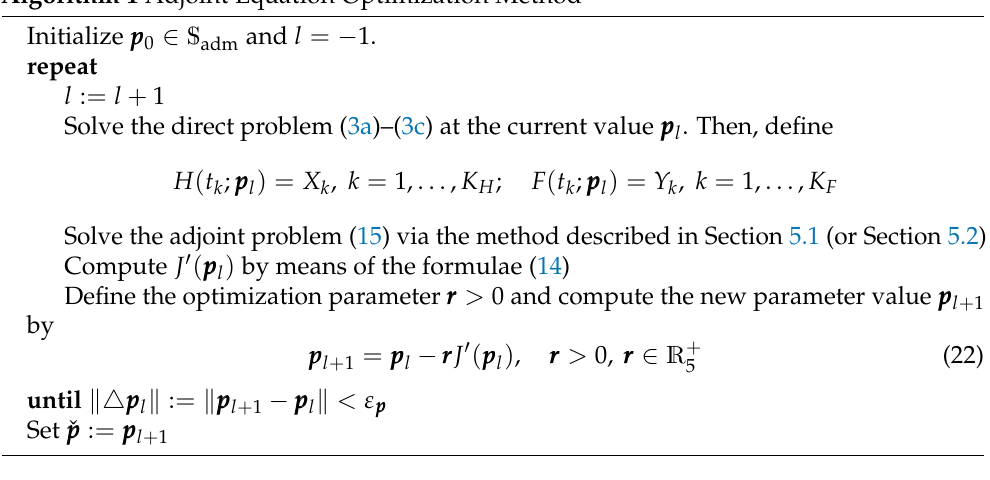
Algorithm 1 Adjoint Equation Optimization